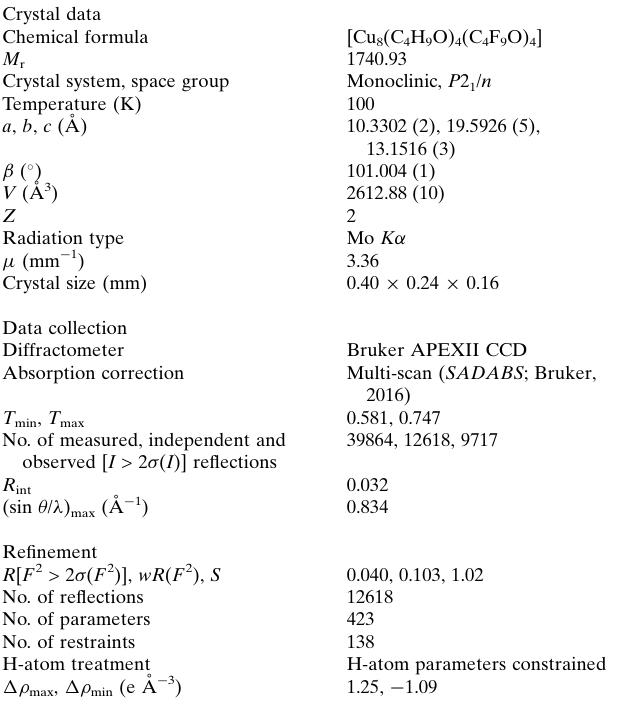
Computer programs: APEX2 and SAINT (Bruker, 2016), SHELXT (Sheldrick 2015 a ), SHELXL2018/3 (Sheldrick, 2015 b ), and SHELXTL (Sheldrick 2008).